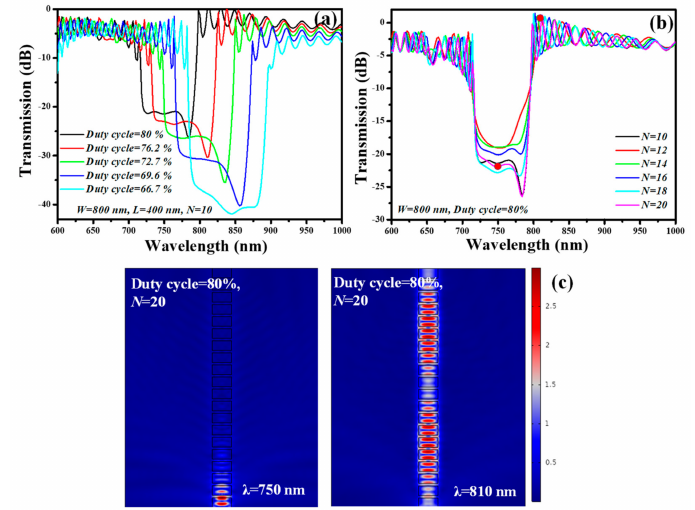
Figure 13. Spectral features of SWG waveguide filter, ( a ) transmission versus DC , ( b ) transmission versus N , ( c ) E-field distribution at λ = 750 nm occurring in the stopband ( left ) and λ = 810 nm ( right ) occurring above λ Bragg